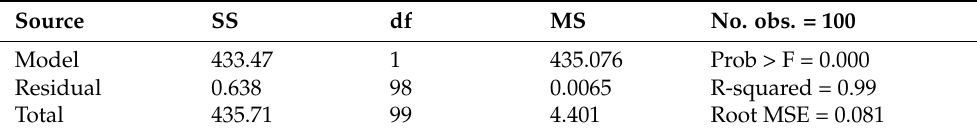
Table 1. ANOVA analysis of length vs. resistance of SS conductive yarn.